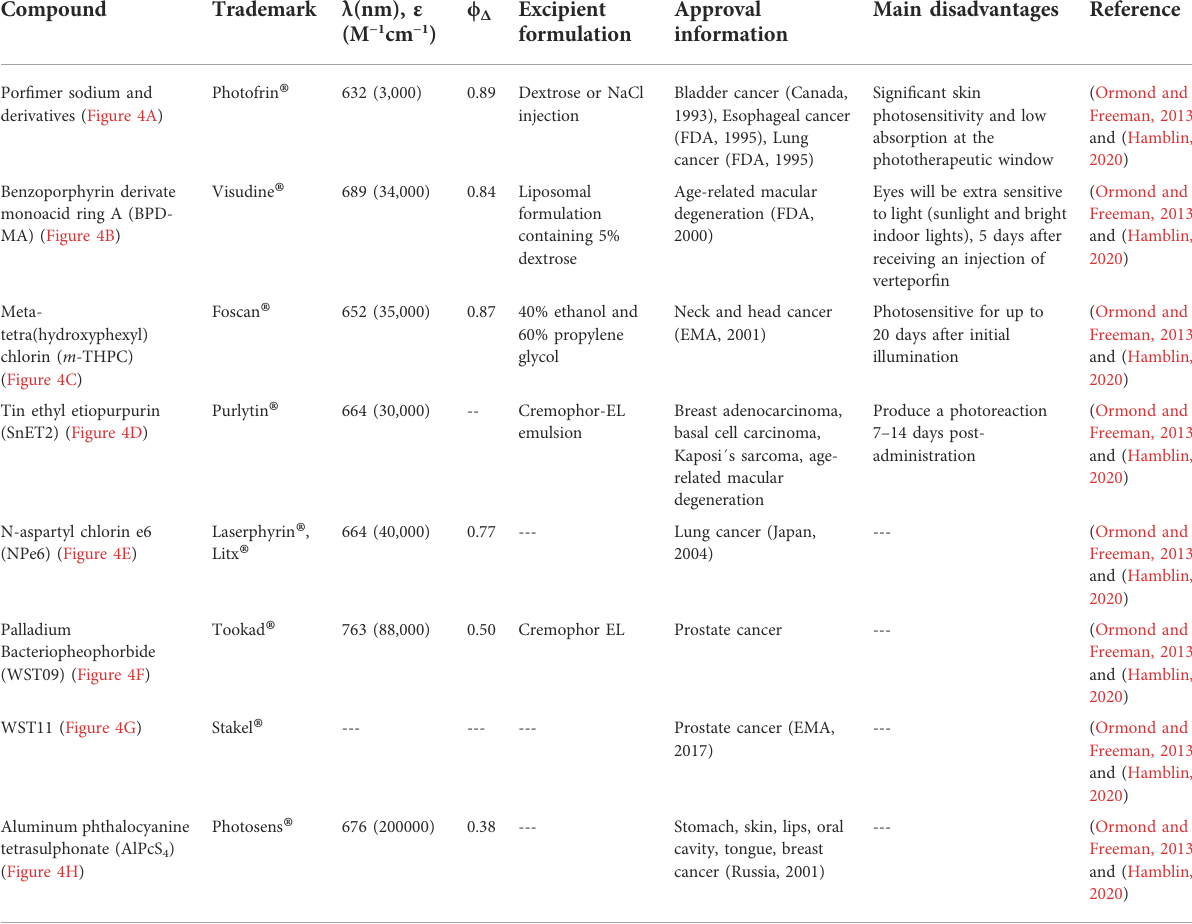
TABLE 1 Properties of approved PS for PDT by regulatory agencies (Ormond and Freeman, 2013), (Hamblin, 2020).